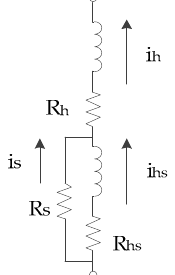
Figure 2. The equivalent circuit of the coil.